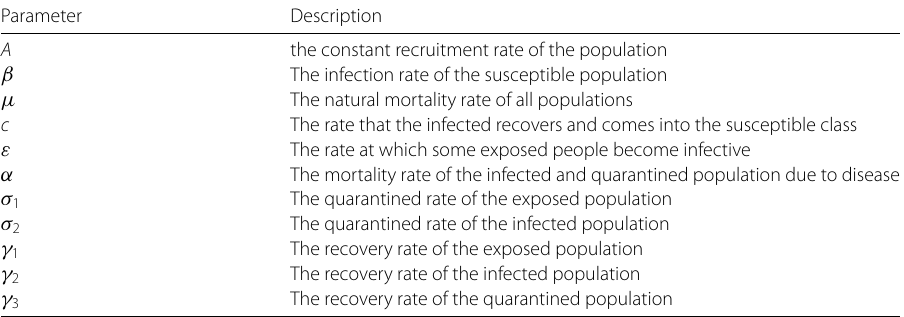
Table 1 Parameters and their meanings in this paper Parameter